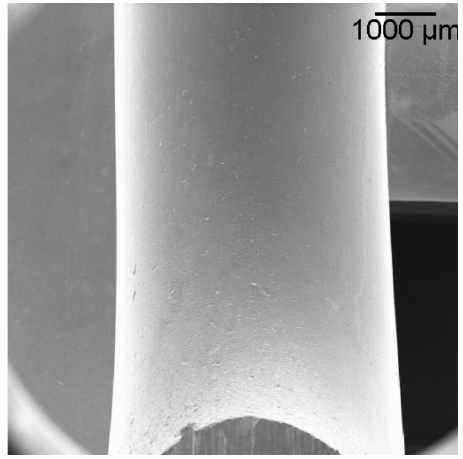
FIG. 19. SEM micrograph of PBG